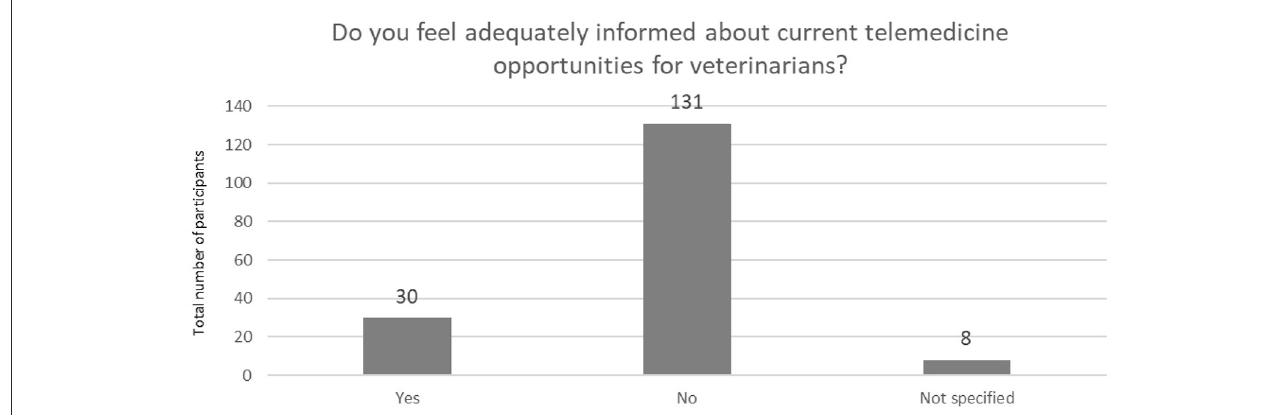
FIGURE9 Information about current telemedicine opportunities for veterinarians ( N = 169).